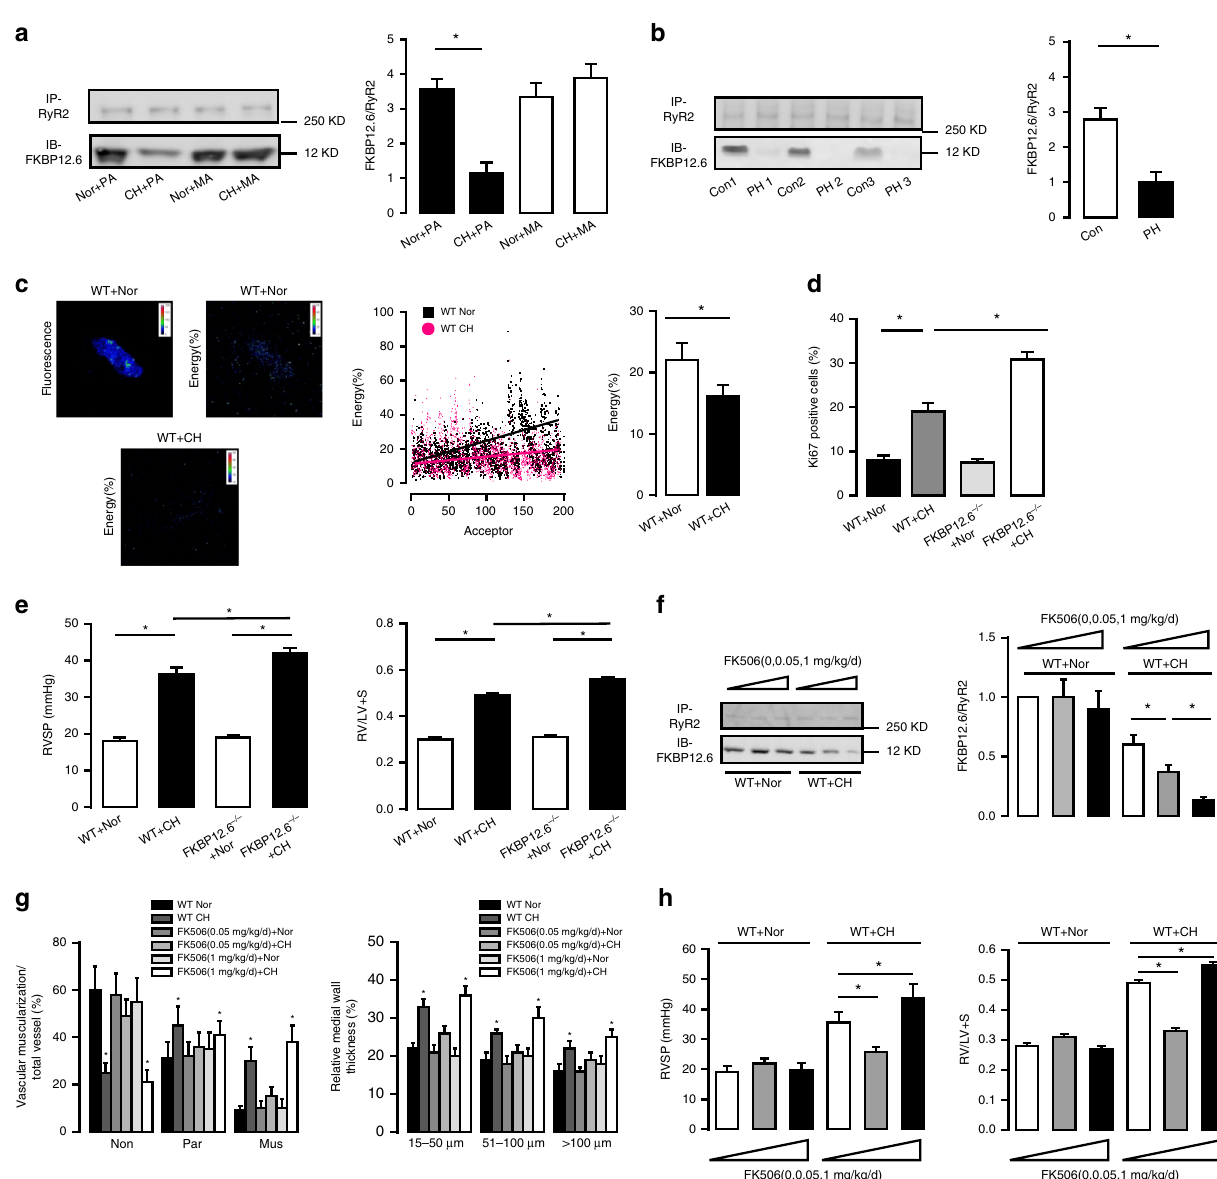
Fig. 4 CH induces dissociation of FKBP12.6 from RyR2 and the effect of PH. a Representative Co-IP and western blot of RyR2 and FKBP12.6 from CH induced PH. FKBP12.6 is immunoprecipitated with an anti-RyR2 antibody and then immunoblotted with anti-FKBP12.6 antibody. Tissue is taken from Nor and CH mice ’ s pulmonary arteries (PA) and mesentery arteries (MA) ( n = 3 independent studies, 5 mice per study). Bar graph summarizes the effect of CH on the association ratio of FKBP12.6 to RyR2. b Representative Co-IP and western blot of RyR2/FKBP12.6 complex from patients with PH and age- matched non-PH (Con) human PAs. Bar graph depicts the association ratio of FKBP12.6 to RyR2 ( n = 3 independent studies). c Representative pictures of FRET measurement between donor (FKBP12.6) and acceptor (RyR2) in PASMC. At different levels of acceptor, WT Nor PASMC (black spot) transferred more energy than CH PASMC (red spot), which indicates the experiment is independent of acceptor. Bar graph summarizes average percentage of FRET ef fi ciencies between RyR2/FKBP12.6 pairs in Nor and CH PASMC ( n = 5 independent studies). d In vivo PASMC proliferation (Ki-67 staining) after 3 weeks CH in FKBP12.6 − / − mice ( n = 5 independent studies, 50 vessels per study). e Summarized the effect of CH on the RVSP in WT and FKBP12.6 − / − PH mice model. Ratio of RV/LV + S to measure RV hypertrophy ( n = 7 independent studies, 5 mice per study). f Representative Co-IP and western blot of RyR2/FKBP12.6 association from low dosage and high dosage FK506 treatment groups. Bar graphs describe the summarized results of FKBP12.6/RyR2 binding ratio in FK506 treating PH model ( n = 4 independent studies, 5 mice per studies). g In vivo pulmonary vascular remodeling evaluated by proportion of non-(Non), partially (Par), or fully (Mus) muscularized PAs and medial wall thickness ( n = 7 independent studies, 60 vessels per study). h Impact of 3- weeks low dosage FK506 (0.05 mg/kg/d) and high dosage FK506 (1 mg/kg/d) on RVSAP and RV/LV + S, indicating low dosage FK506 has protective effect however high dosage FK506 facilitates the development of PH ( n = 7 independent studies, 5 mice per study). Data are expressed as mean ± standard error. (* P < 0.05, using one-way ANOVA test or Student ’ s t